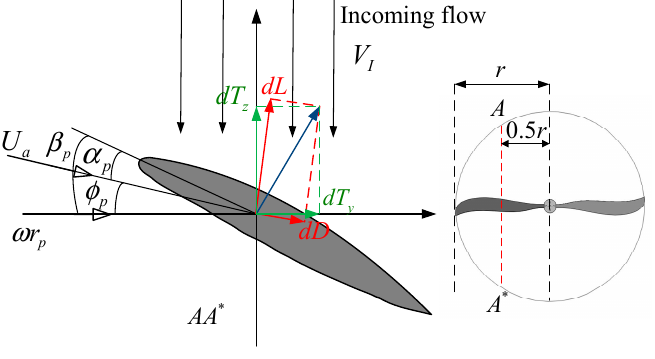
Figure 1. The flow diagram of the navigation reconstruction method.